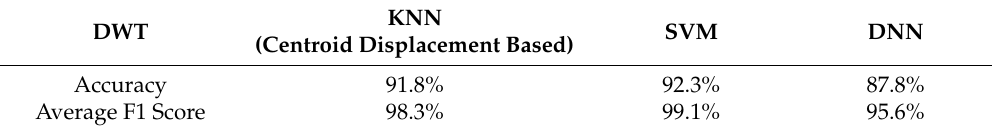
Table 4. Result based on DWT Features.